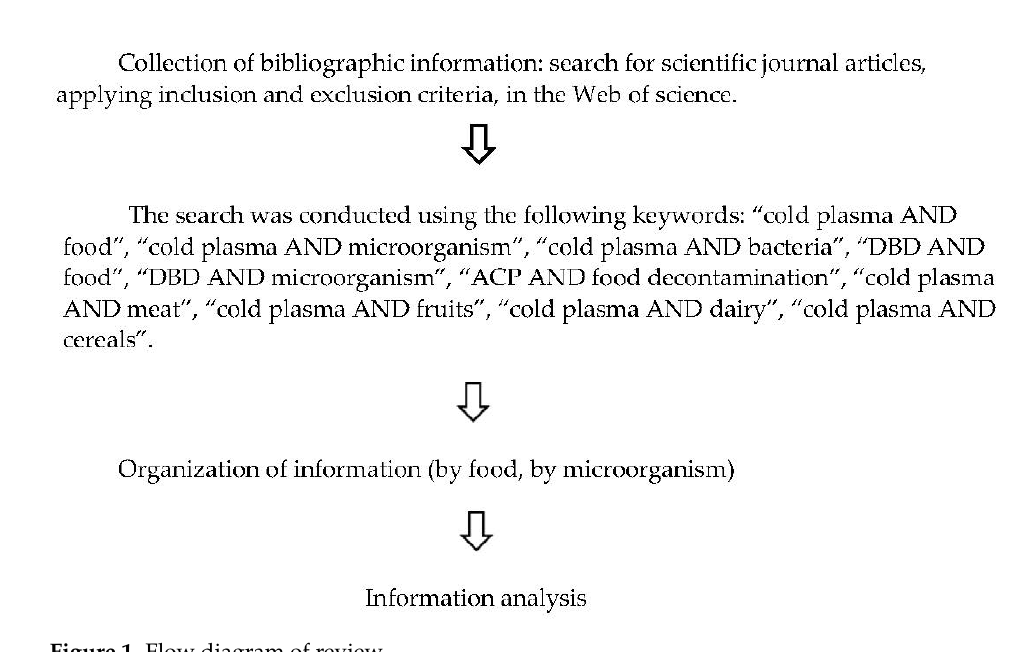
Figure 1. Flow diagram of review.